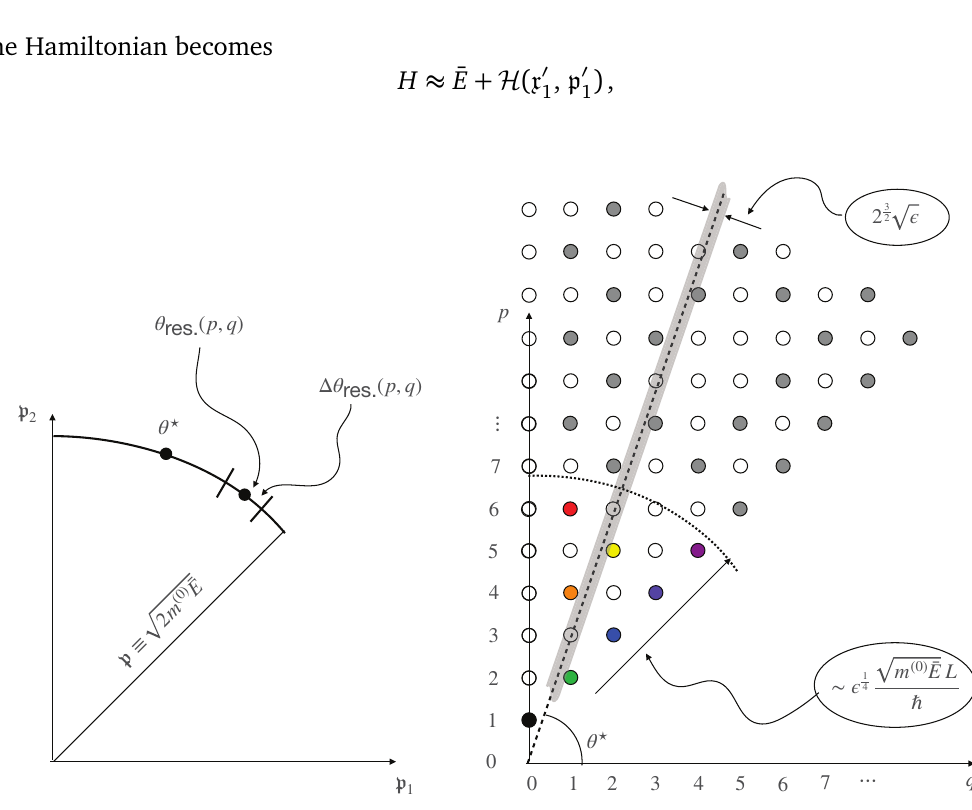
Figure 6: Steps in construction of the classical and quantum Chirikov criteria for an offset of chaos. (a) A point of on an equienergy surface ¯ E in the momentum space, at an angle θ (cid:63) to the horizontal, is shown to lie outside of a nonlinear resonance p : q . (b) As shown in the text, the angular width of a resonance p : q , on an equienergy surface, (cid:112) p 2 + q 2 . As a result, if a point θ (cid:63) belongs to a resonance p : q , is proportional to 1 / the point ( q , p ) must lie in a stripe , in the q , p space. The total width of the stripe (cid:112) 3 ε . Classically, the stripe is infinitely long, and any point θ (cid:63) can be shown to be 2 2 belongs to an infinite number of allowed resonances (colored and grey points, color scheme is the same as at Figs. 2-3. Every point on the equienergy surface turns out to be dynamically connected to any other point there resulting in chaos. Quantum (cid:112) p 2 + q 2 (cid:174) ε 1 / 4 ¯ n , with mechanics sets an upper bound on the length of the stripe: ¯ n being the typical quantum number along any of thee two directions. As a result, both the appearance of the first resonance (at ε (cid:166) ∼ 1 / ¯ n 2 ) and the chaos threshold 2 (at ε (cid:166) 1 / ¯ n 3 ) requires a finite strength perturbation